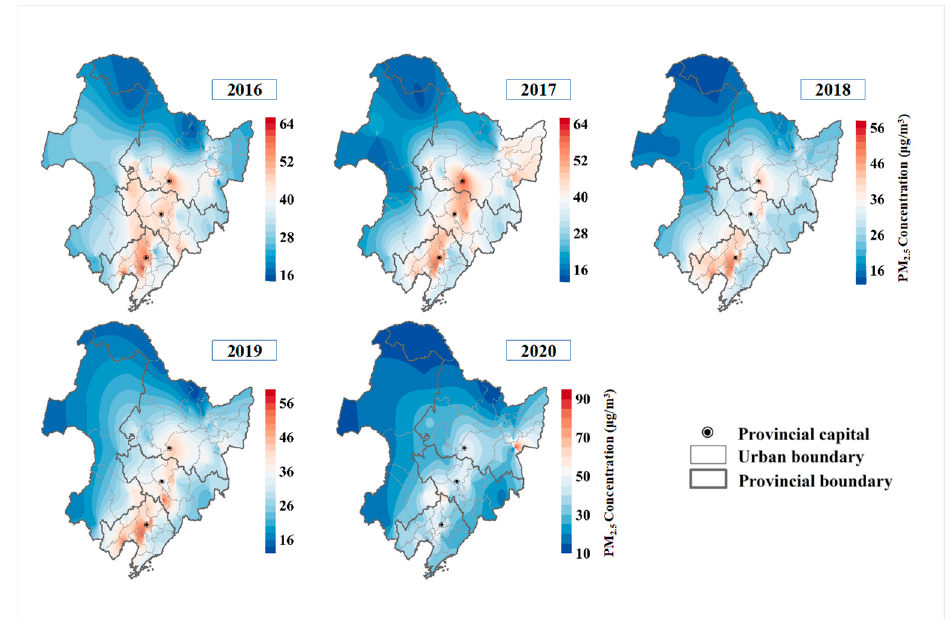
Figure 5. Spatial distribution of PM 2.5 concentration in Northeast China from 2016 to 2020.